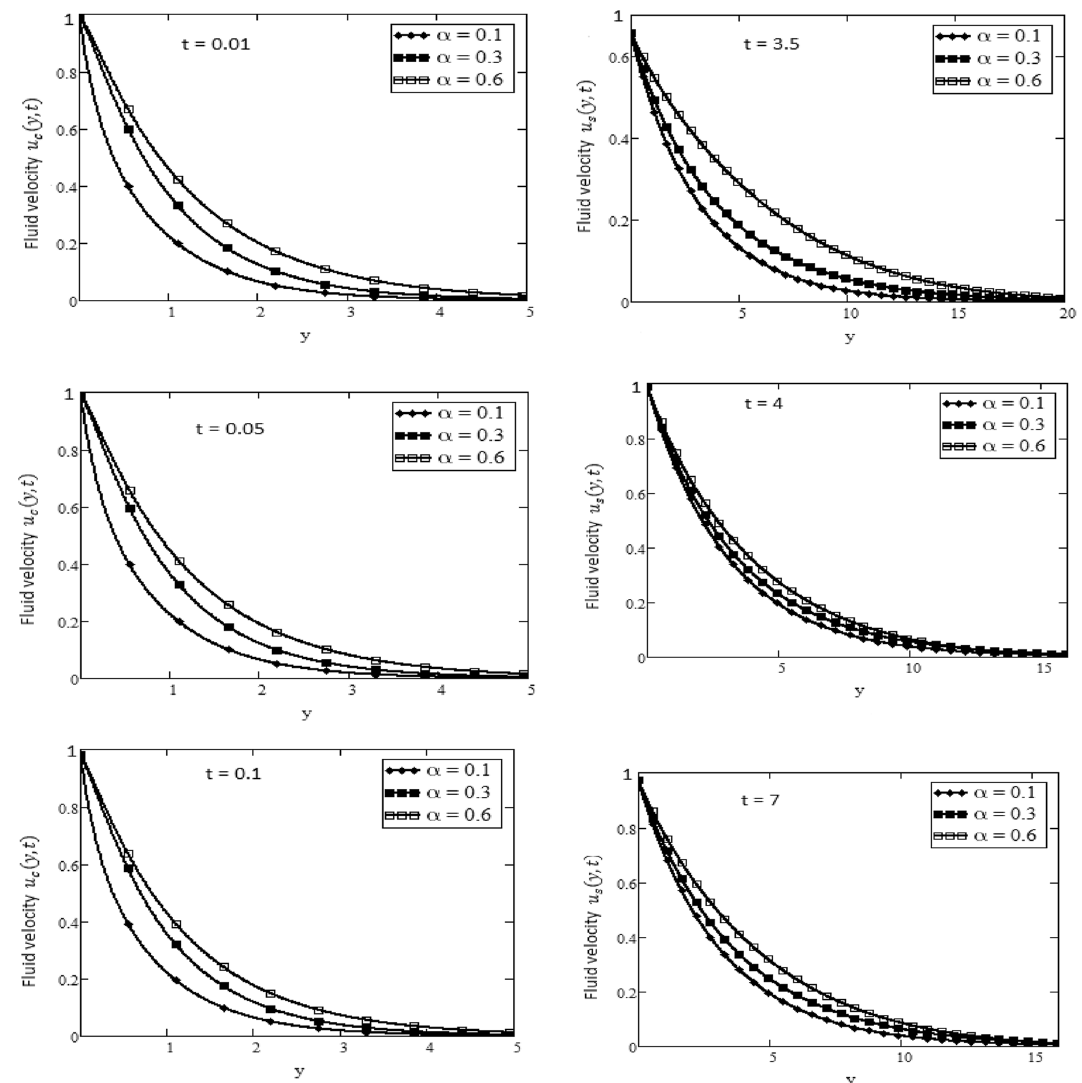
Figure 2. Velocity plot in the form of cosine and sine oscillation or various values of α of at t , when Pr = 7 , M = 15